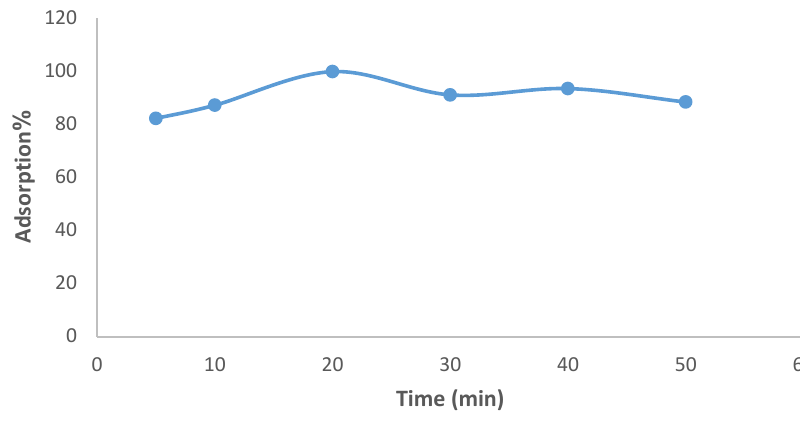
Figure 3. Effect of pH on the adsorption of methyl orange dye at a concentration of 20 mg/L